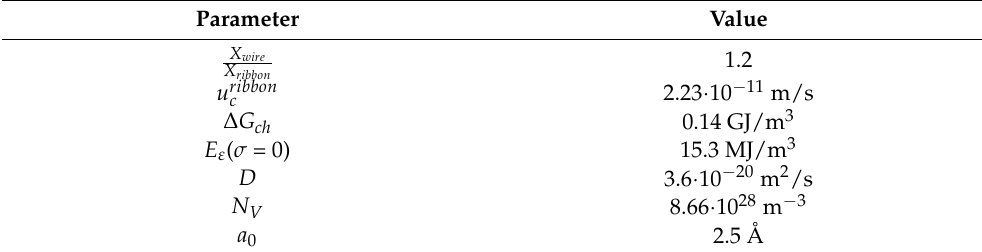
Table 1. Data used for the calculations.